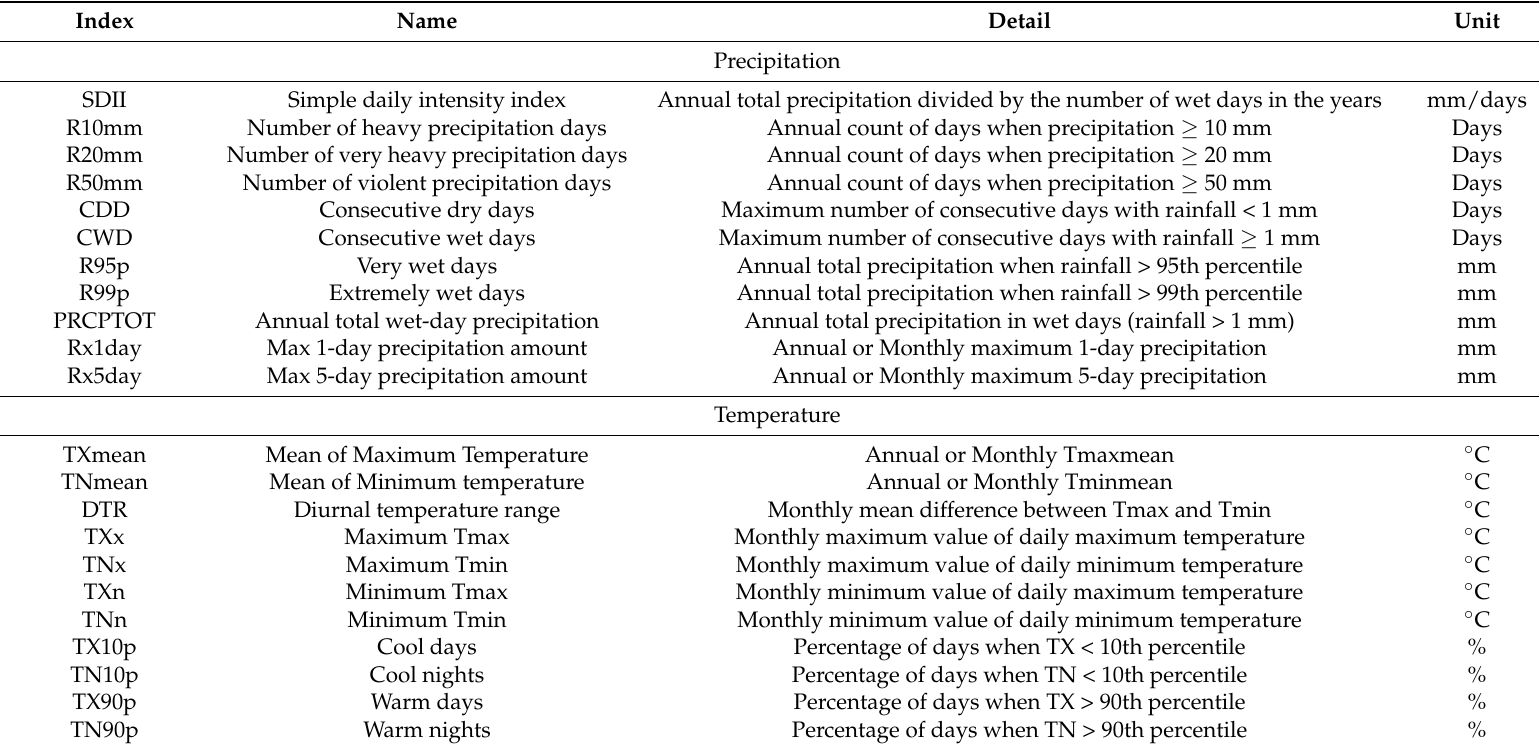
Table 2. Precipitation and temperature indices used in this